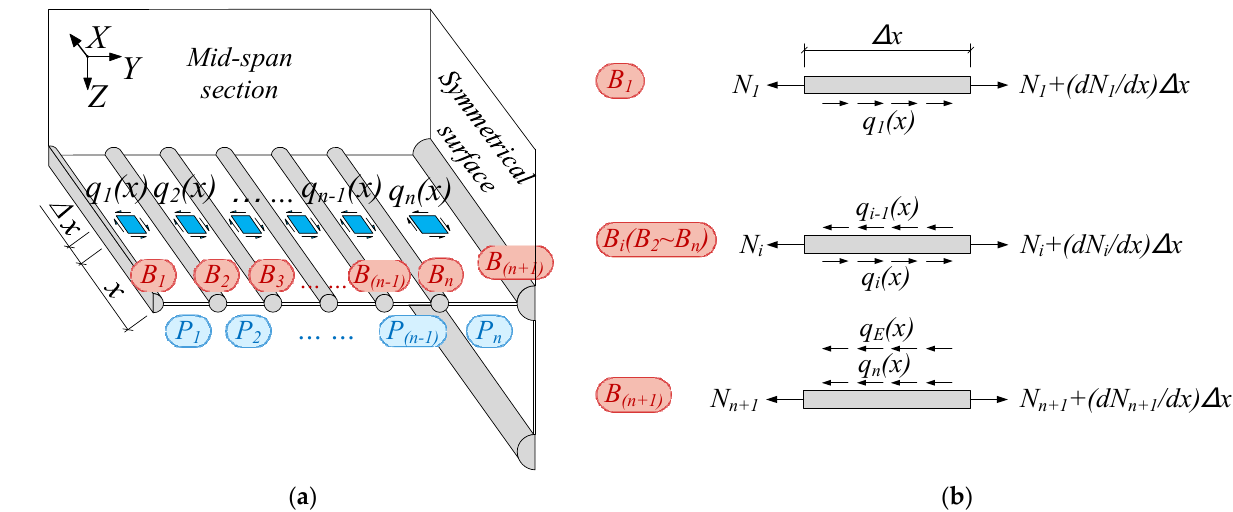
Figure 5. Mechanical model: ( a ) 1/4 simplified structure; ( b ) stiffener micro-elements.